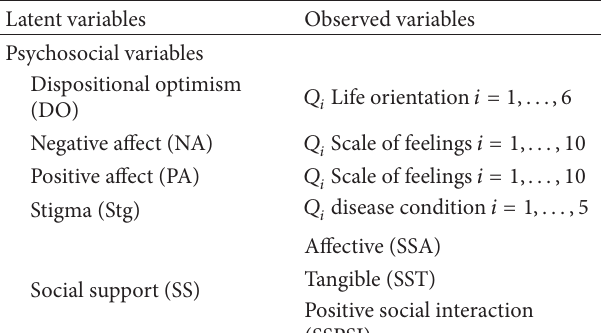
Table 1: Observed and latent variables in the assessment of quality of life of obese